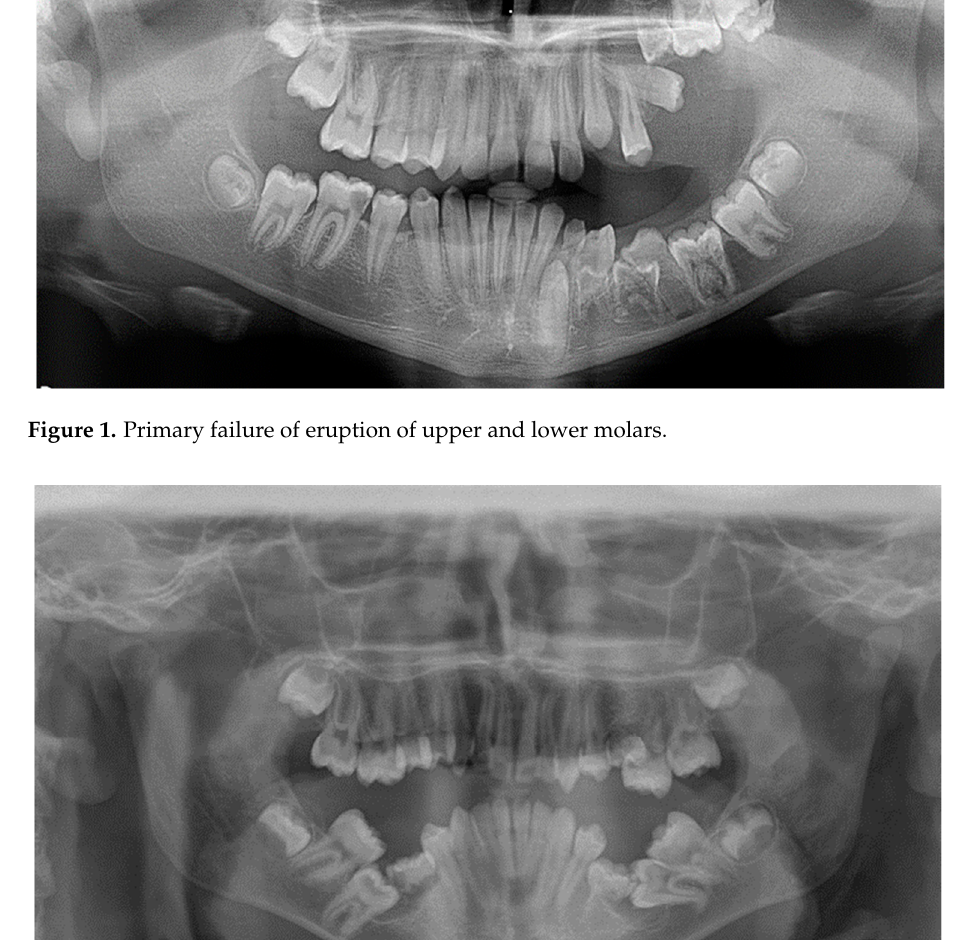
Figure 3. Ectopic eruption of upper left canine.